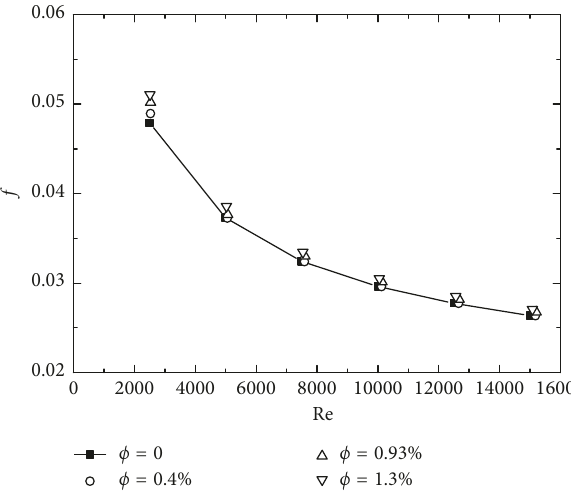
Figure 5: Friction factor as a function of the Reynolds number by different volume concentrations ( r